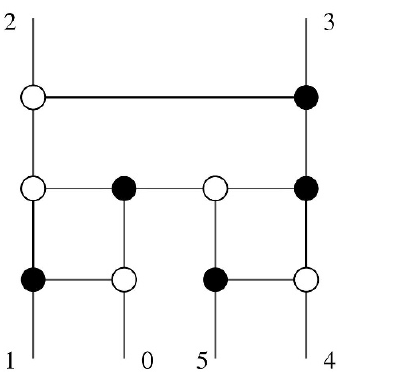
Figure 17 . On-shell diagram from which (cid:12)gure 16 can be obtained by taking a forward limit and adding a decorated BCFW